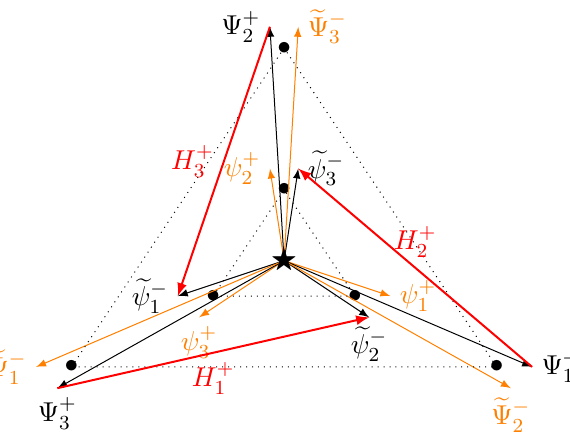
Figure 22. Set-up C [ (cid:22) L ] + C [ (cid:22) R ] + D with a Z 3 -invariant Higgs con(cid:12)guration, where the point brane D is depicted in the center and C [ (cid:22) L ] corresponds to the outermost brane. We sketch the chiral intra-brane fermions (cid:9), e (cid:9) between C [ (cid:22) L ] and D as well as , e between C [ (cid:22) R ] and D . The fermions (cid:9) and e can be linked by maximal inter-brane Higgs H , ~ H between C [ (cid:22) L;R ]. The chirality of the fermionic zero modes is indicated by the sign (cid:6) , which is inherited from the Weyl chamber.